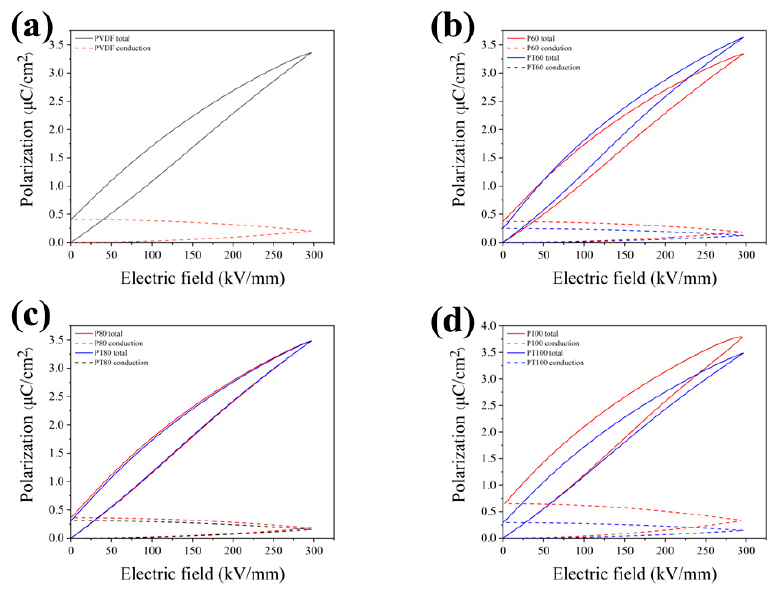
Figure 5. Deconvolution of charge transport contribution from P–E loops, i.e., P-E loops and conduction loss of ( a ) PVDF, ( b ) P60 and PT60, ( c ) P80 and PT80, ( d ) P100 and PT100.